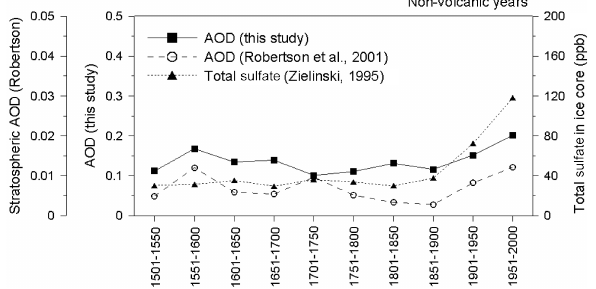
Fig. 5. Total AOD from paintings and in the stratosphere and total sulfate in Greenland ice core (in ppb) averaged over 50-year inter- vals for “non-volcanic” years during the period